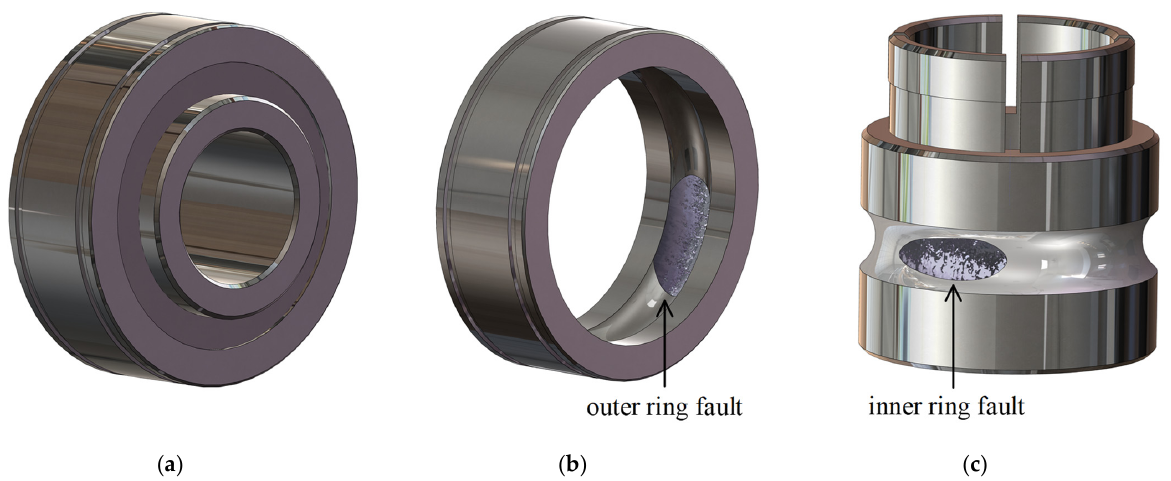
Figure 4. Sketch maps of the rolling bearings in typical stages. ( a ) In health; ( b ) with an outer ring fault; ( c ) with an inner ring fault. Table 3. Theoretical values of fault characteristic frequencies for each